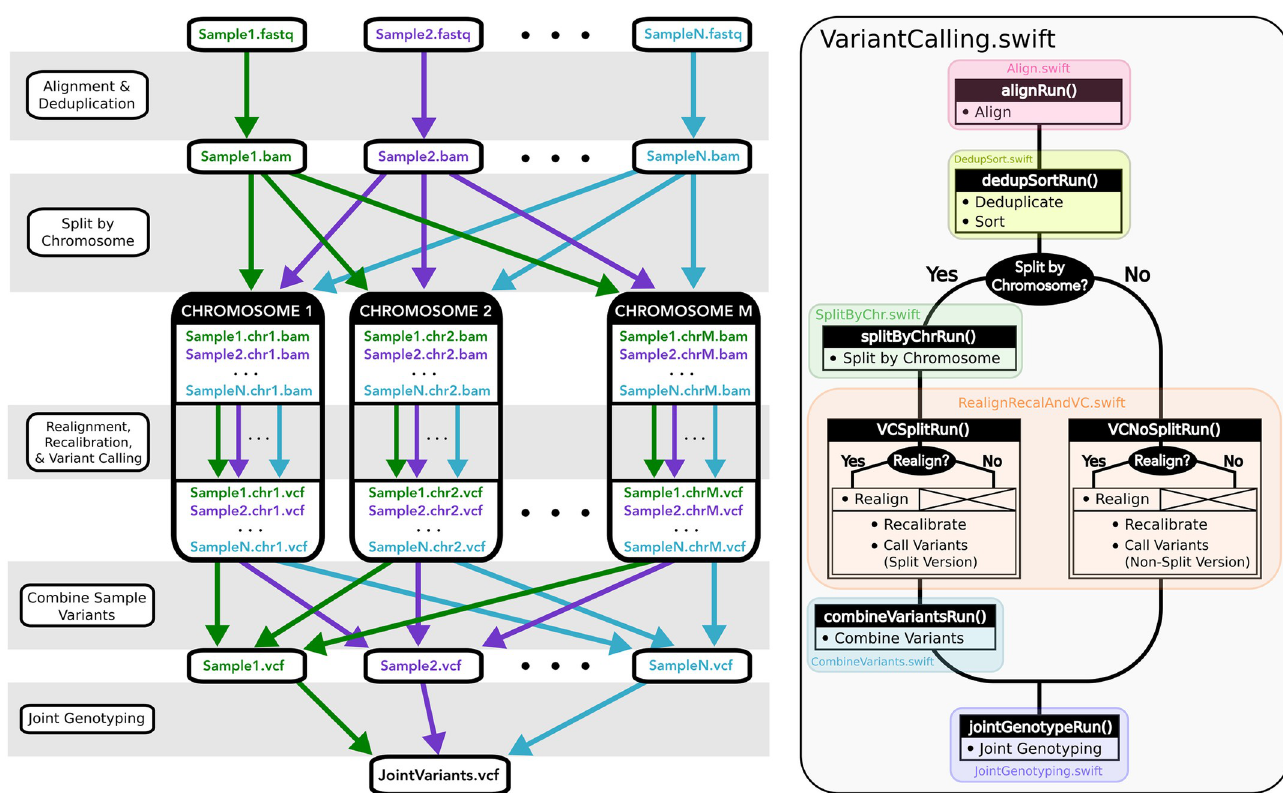
Fig 1. Swift/T variant calling code, under the hood. Left: Patterns of parallelization implemented in our Swift/T variant calling workflow. Right: Colored blocks represent the different stages of the workflow. Black blocks indicate methods within the respective